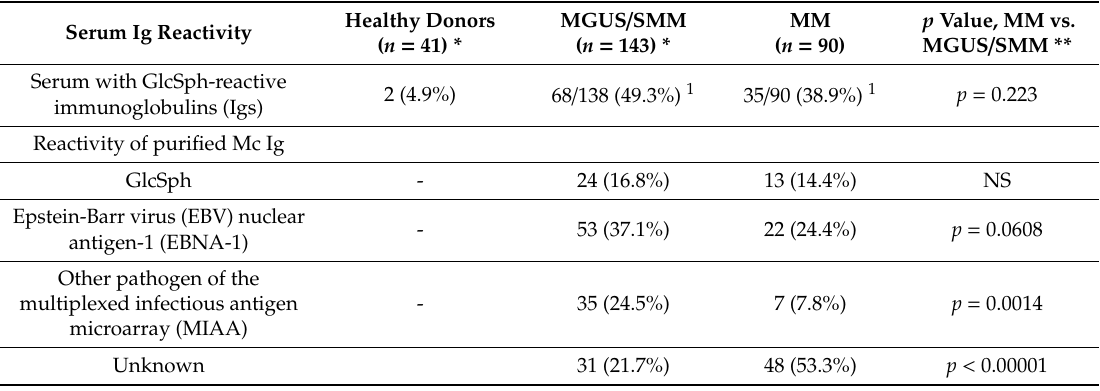
Table 1. Glucosylsphingosine (GlcSph)-reactivity of serum Igs and specificity of monoclonal Igs of monoclonal gammopathy of undetermined significance (MGUS) / smoldering multiple myeloma (SMM) and multiple myeloma (MM)